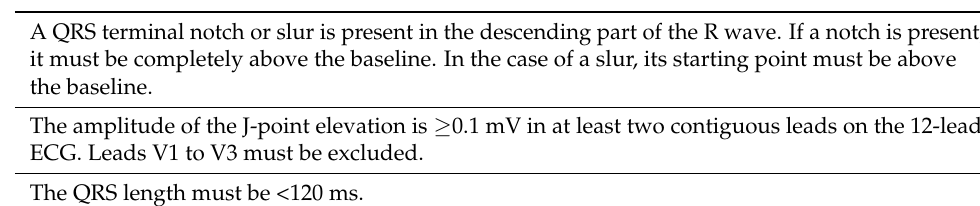
Table 1. The diagnostic criteria for ERP formulated in the recent consensus paper [13]. For the diagnosis of ERP, all of the following criteria must be